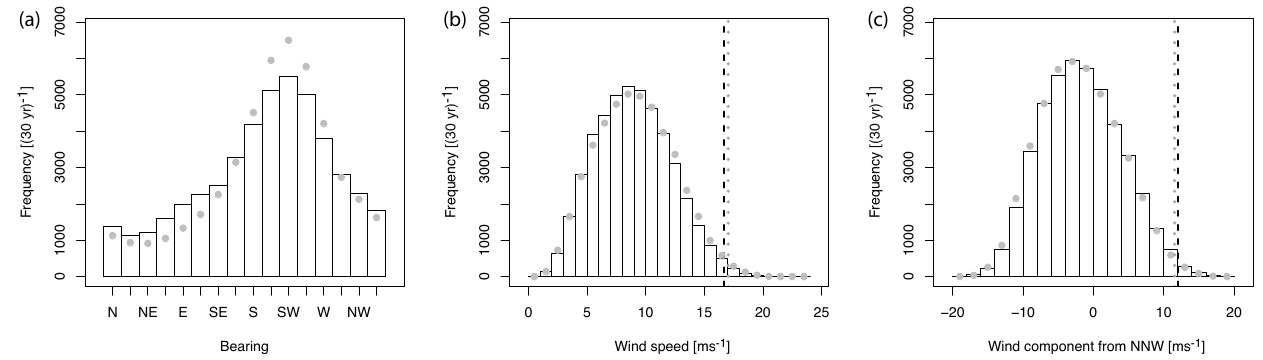
Fig. 2. DJF Climatologies of wind directions (a) , wind speed (b) and NNW wind component (c) averaged over the North Sea box (shaded dark grey in Fig. 1). Bars show the distribution for the current climate (1950–1980) and dots for the future (2070–2100). The dashed vertical lines in (b) and (c) mark the location of the 99% quantiles of the current (black) and future (grey)